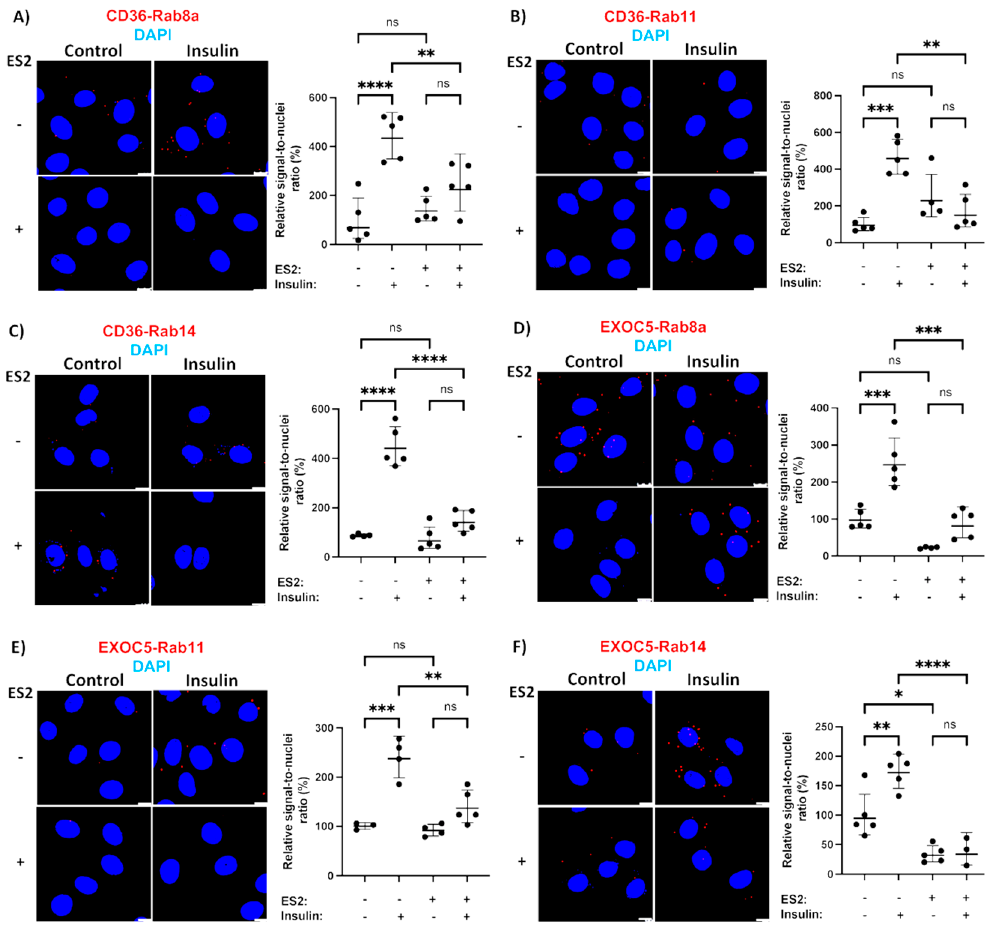
Figure 4. Identifying Rab GTPases associated with the exocyst and CD36 in response to insulin. ( A – C ) Microscopic images and quantification of a PLA evaluating proximity of Rab8a, Rab11 and Rab14 with CD36 in L6 GLUT4myc myoblasts show higher association rates of all three Rabs with CD36 following insulin treatment. In the presence of ES2, insulin fails to trigger such an increase in target protein proximity. ( D – F ) Microscopic images and quantification of a PLA evaluating proximity of Rab8a, Rab11 and Rab14 with EXOC5 in L6 GLUT4myc myoblasts following insulin treatment demonstrate Exoc5 recruitment to Rabs 8a, 11 and 14. This recruitment is inhibited by treatment with ES2. PLA signals are shown in red; DAPI stain is in blue. Images are representative of three independent experiments. Scale bars: 10 μ m. Data are presented as means ± S.D normalized to controls. * p < 0.05; ** p < 0.01; *** p < 0.005; **** p < 0.0005; ns: p > 0.05.